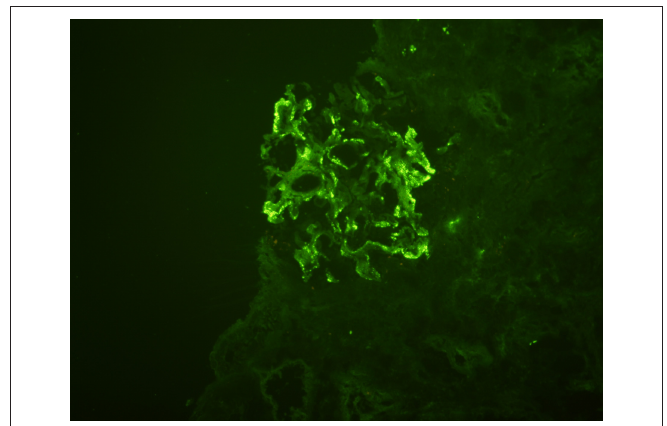
Figure 2. Granular and dominant immunoglobulin A deposition with severity index of +2 located along the mesangial area on immunofluorescence microscopy at ×